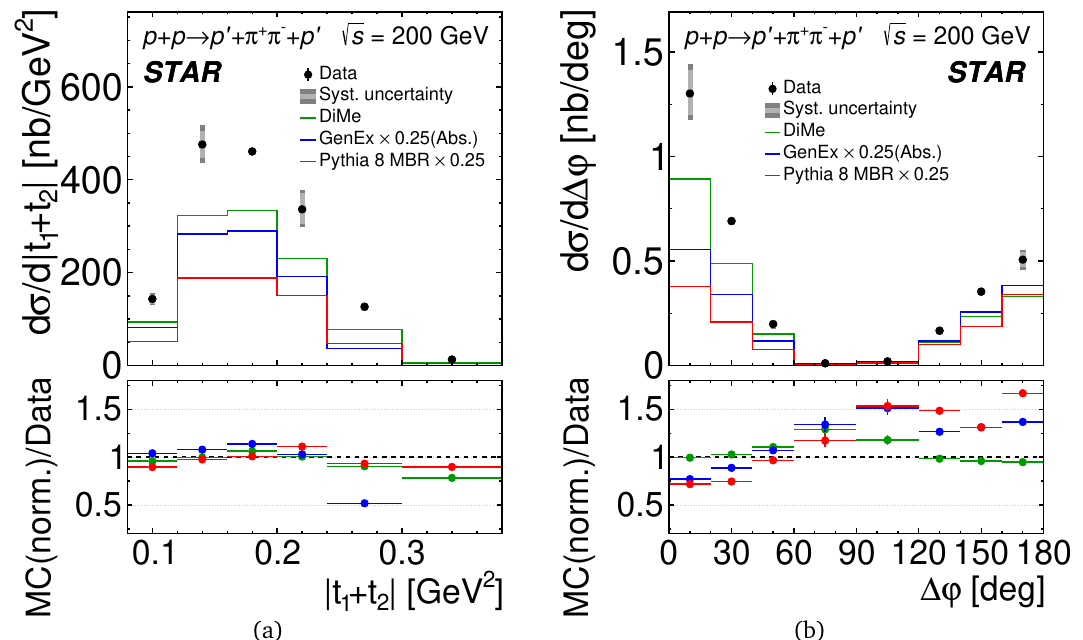
Figure 1: Differential fiducial cross sections for CEP of π + π − pairs as a function of (a) the sum of the squares of the four-momentum transfers in the proton vertices, and (b) the difference of azimuthal angles of the forward-scattered protons [ 5 ] . Data are shown as solid points with error bars representing the statistical uncertainties. The typical systematic uncertainties are shown as grey boxes for only a few data points as they are almost fully correlated between neighbouring bins. Predictions from Monte Carlo models GenEx [ 1 ] , DiMe [ 2 ] and MBR [ 3 ] are shown as